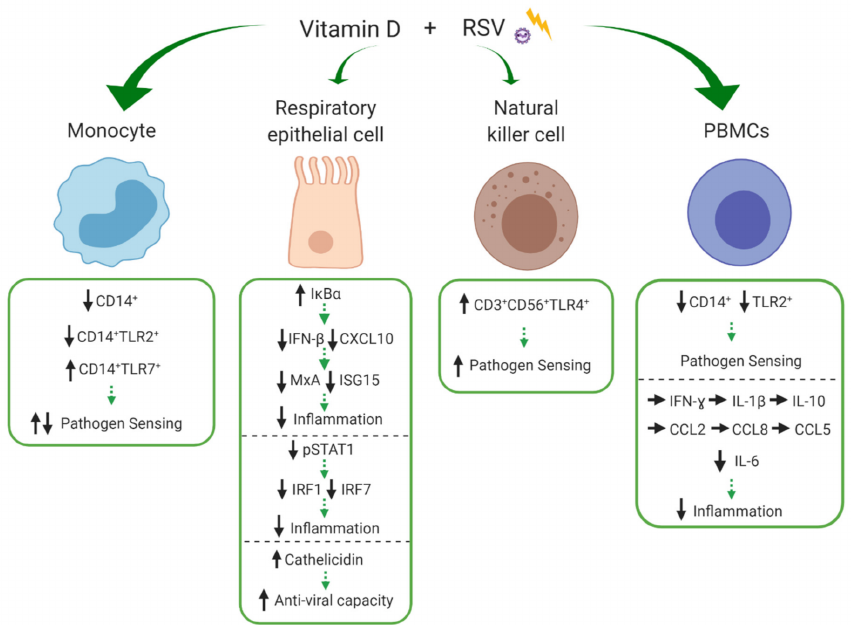
Figure 4. Effects of vitamin D on innate cell subsets in response to respiratory syncytial virus (RSV). Vitamin D differentially modulates expression of pathogen recognition receptors, CD14, toll-like receptor 2 (TLR2), TLR4 and TLR7 on monocytes, natural kills (NK) cells and peripheral blood mononuclear cells (PBMCs) altering their pathogen sensing capacity. Vitamin D increases inhibitor of kappa B alpha (I κ B α ) and decreases signal transducer and activator of transcription (STAT1) phosphorylation in respiratory epithelial cells, resulting in decreased production of the chemokine; C-X-C motif chemokine ligand 10 (CXCL10) and of antiviral agents; interferon- β (IFN- β ), myxovirus resistance protein A (MxA), IFN-stimulated protein of 15kDa (ISG15), IFN regulatory factor 1 (IRF1) and IFR7, overall potentially reducing inflammation. Cathelicidin expression within respiratory epithelial cells is increased by vitamin D, potentially increasing anti-viral capacity. Vitamin D reduces IL-6 in PBMCs but has not impact on IFN- G , IL-1 β , IL-10, C-C motif chemokine ligand 2 (CCL2), CCL8, and CCL5. ↑ / ↓ indicates increase or decrease and → indicates no difference/change to response during immune stimulation with versus without the experimental addition of vitamin D. Green arrows indicate potential net effect. (Created with BioRender.com